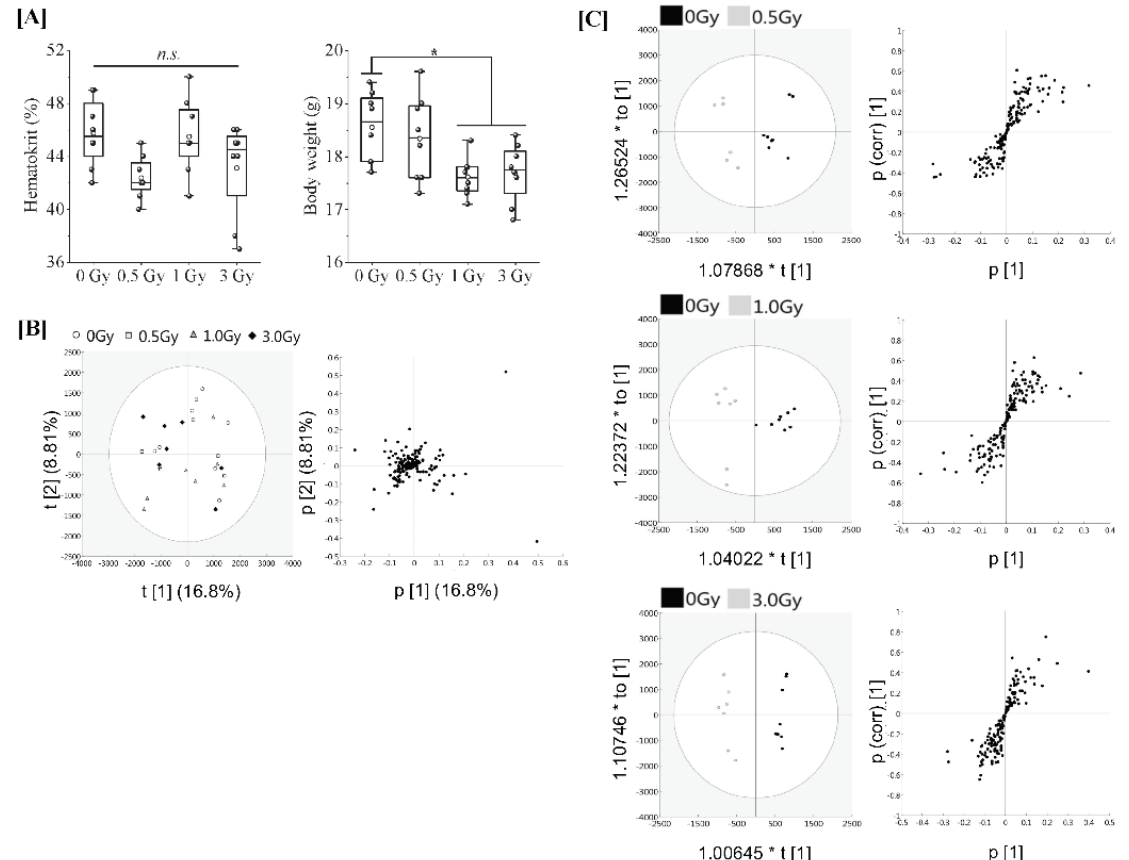
Figure 1. Proteomic analysis of serum from mice exposed to single TBI in in vivo model. [ A ] Eight- week-old female C57BL/6JJcl mice were randomly divided into 4 groups with more than 8 mice per group and subjected to varying TBI doses of 0, 0.5, 1 or 3 Gy of X-rays at a dose rate of 1.0 Gy/min. Peripheral blood was harvested 24 h after TBI from the orbital venous plexus of mice and placed at room temperature for at least 30 min to allow blood clotting for serum collection (in vivo model). Body weight changes and haematocrit values at the time of serum collection. Statistically significant differences were evaluated by a one-way ANOVA and the multiple comparison tests; p < 0.05 (*). [ B ] PCA score scatter plot of the serum proteome. Each dose treatment group of the samples are represented as shown in the ( left ) figure, respectively. Uncharacterized samples are plotted at the center, and those with features are plotted at a distance from the center (right) figure. Similar features are plotted at close positions. [ C ] The OPLS-DA model to discriminate the serum proteome of each irradiated mouse. The score scatter plot and S-plot are represented. The ellipse in the score scatter plot indicates the Hotelling T2 (0.95) range for each